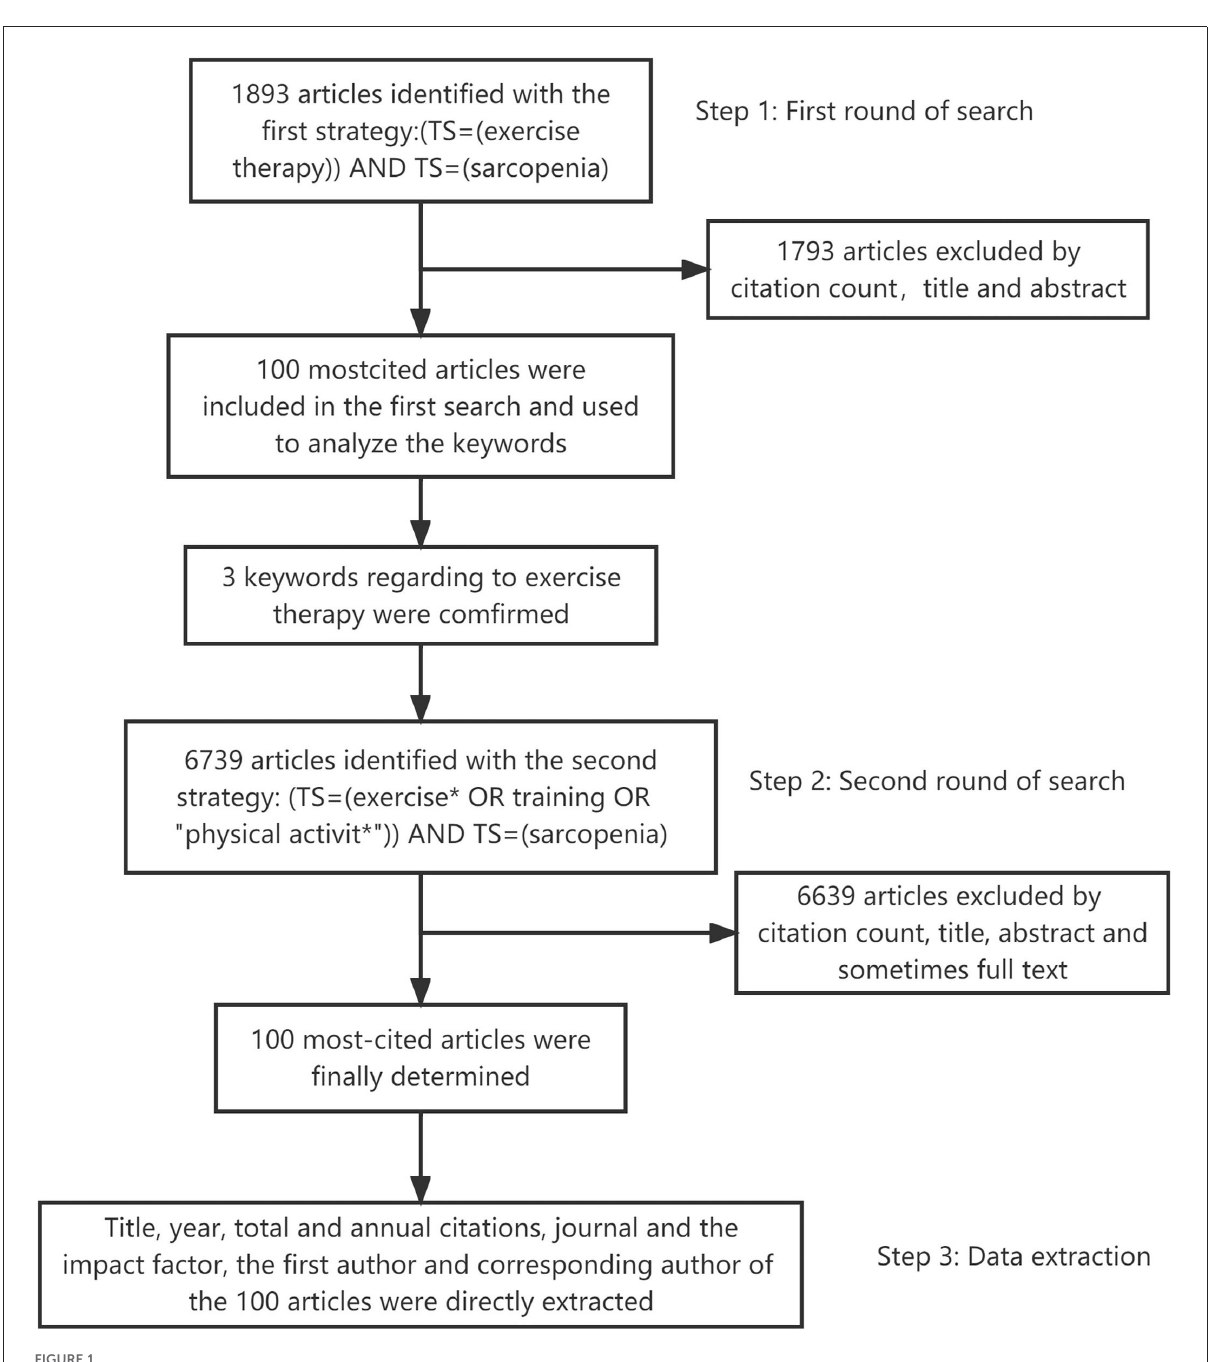
FIGURE1 Flowchart showing the approach to identifying the top 100 most-cited articles.